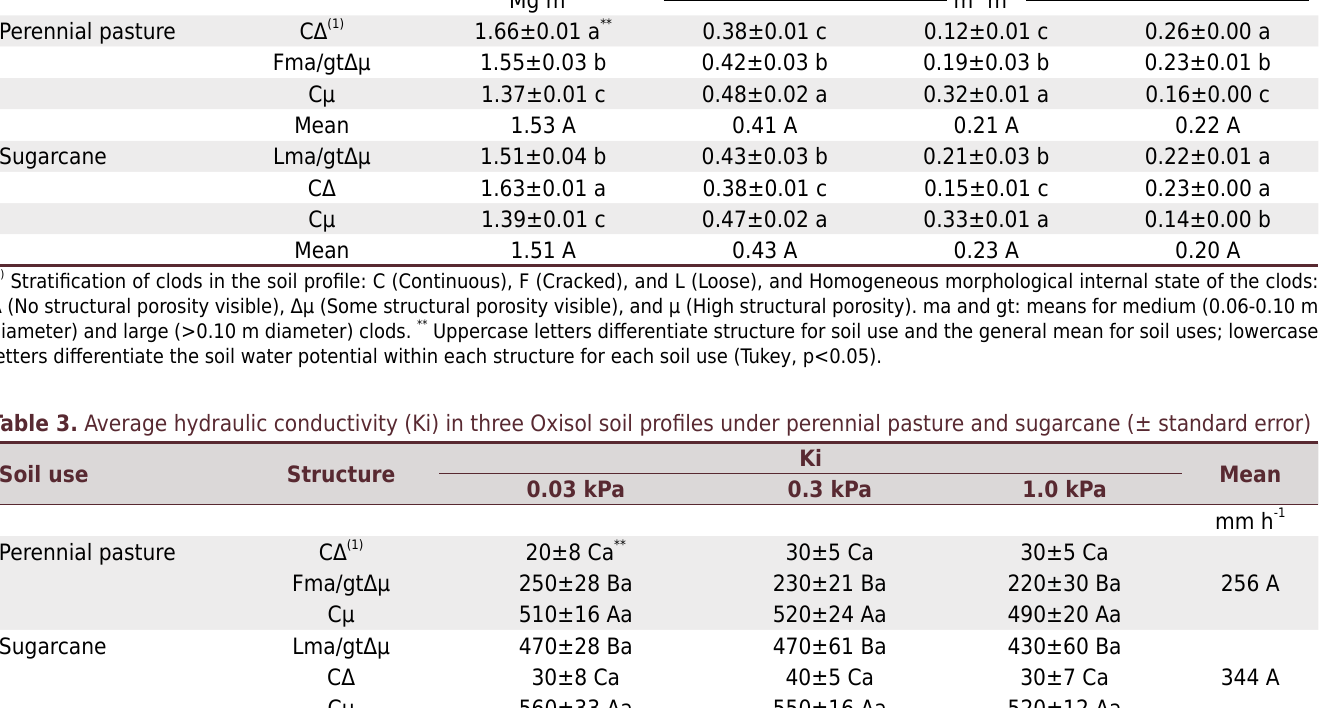
520±12 Aa (1) Stratification of clods in the soil profile: C (Continuous), F (Cracked), and L (Loose), and Homogeneous morphological internal state of the clods: Δ (No structural porosity visible), Δμ (Some structural porosity visible), and μ (High structural porosity). ma and gt: means for medium (0.06-0.10 m diameter) and large (>0.10 m diameter) clods. ** Uppercase letters differentiate structure for soil use and the general mean for soil uses;